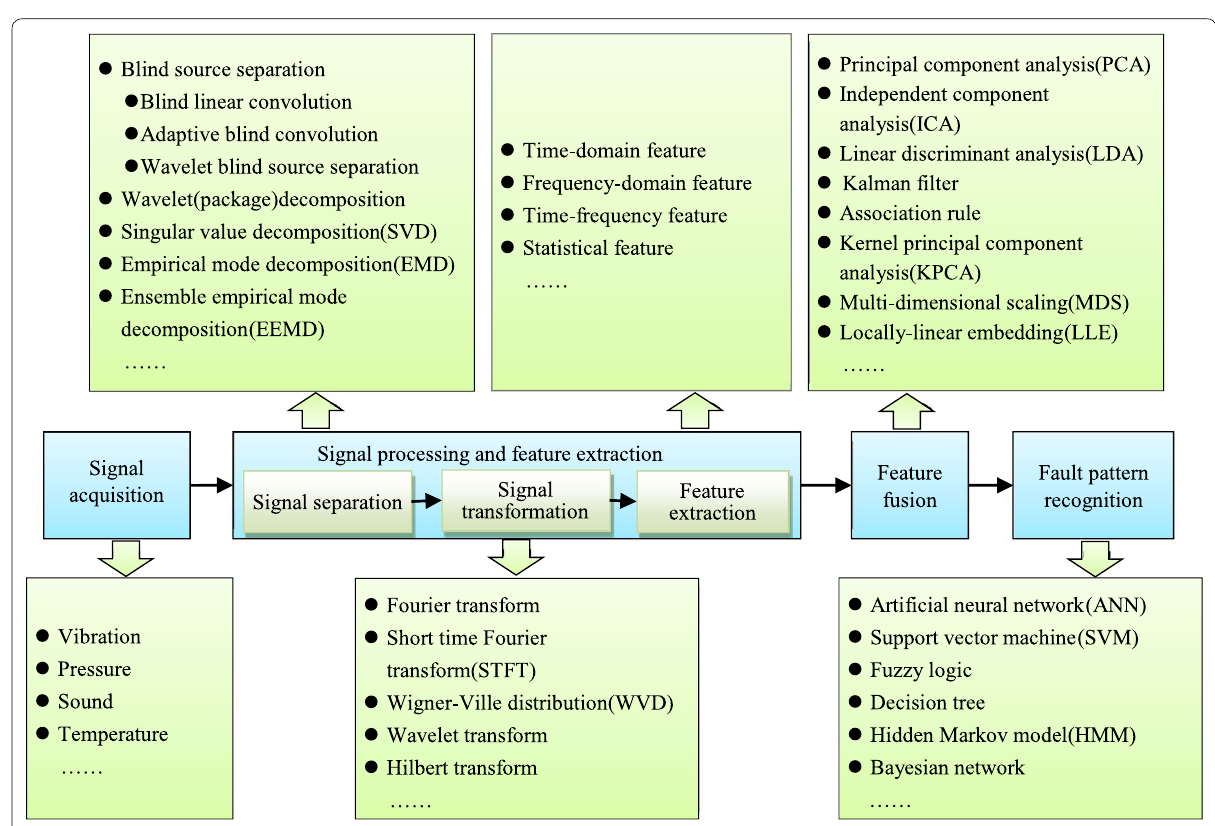
Figure 1 Processes of signal-based intelligent fault diagnosis and the main methods used in each